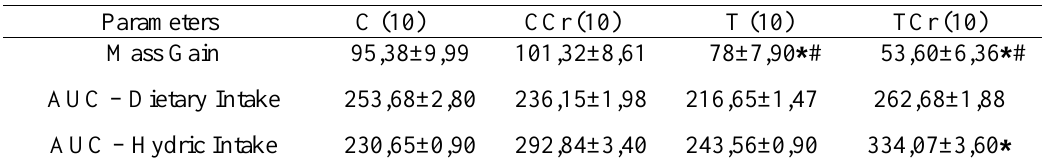
Table 2. Body mass gain (g), area under the curve of dietary intake (g/100 g rat x 4 weeks) and area under the curve of hydric intake (ml/100 g rat x 4 weeks) of the animals at the end of the experiment.